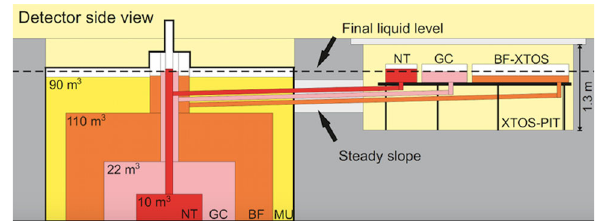
Fig. 10 Detector side view for the far detector case including the con- nection between the detector chimneys and the expansion tank system (XTOS), made with 3/4-in.